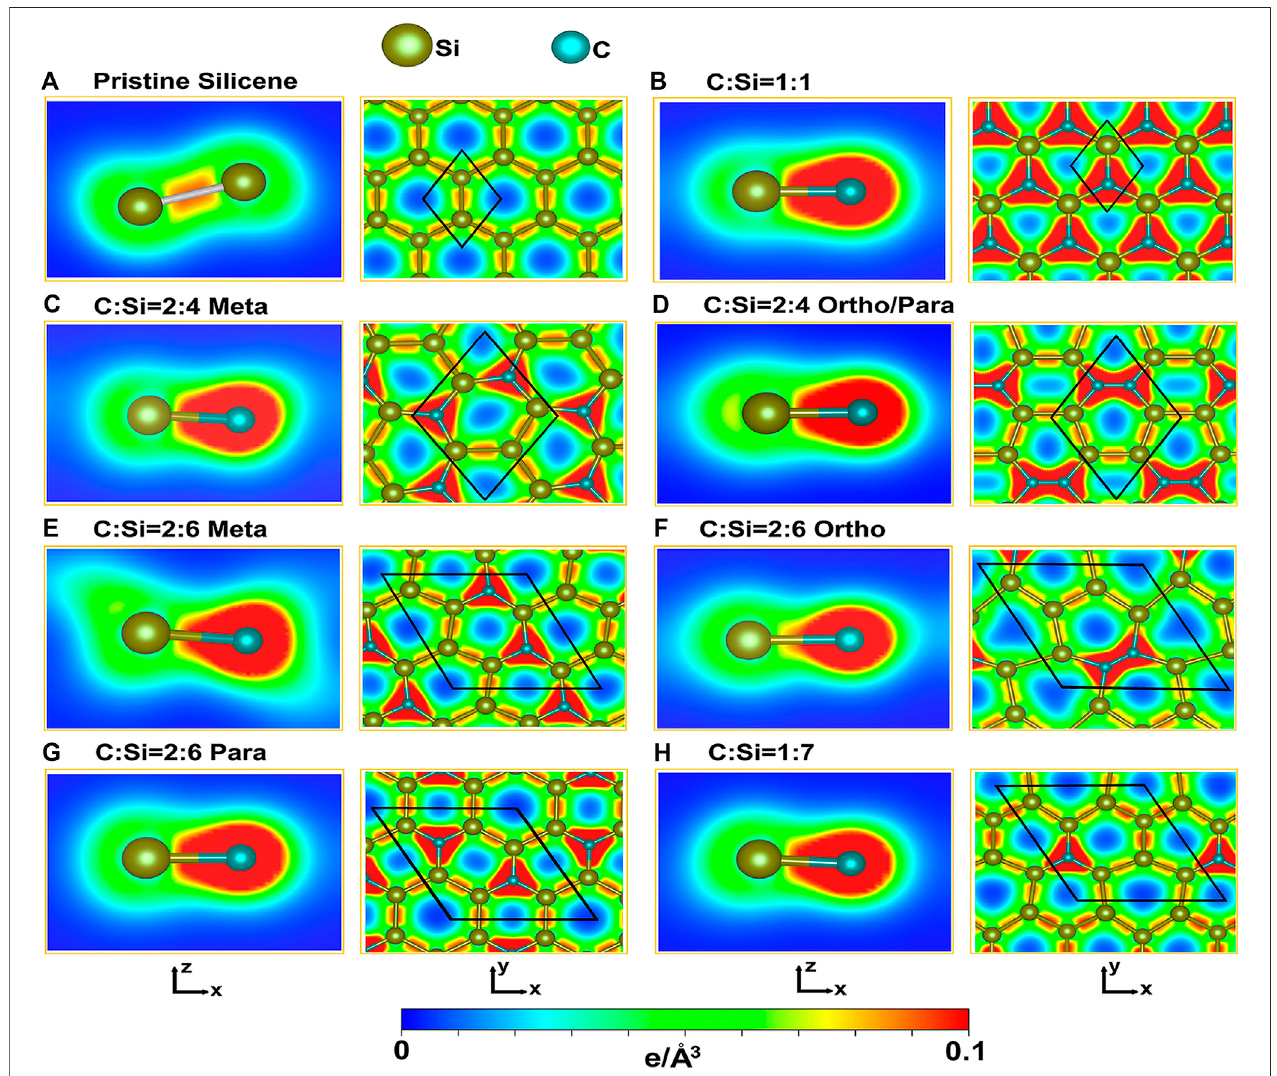
FIGURE 4 | The spatial charge densities of the carbon-substituted silicene materials for the various concentrations and con fi gurations: (A) the absence of guest atoms, (B) [1:1], (C) [2:4]-meta, (D) [2:4]-ortho-/para, (E) [2:6]-meta, (F) [2;6]-ortho, (G) [2:6]-para,and (H) [1:7]conditions.Theyareshownonthe[ x , z ]and[ x , y ]planes, clearly illustrating the π and σ chemical bondings and their orthogonality/non-orthogonality. The unit cells are represented by the black parallelogram/rhombus.